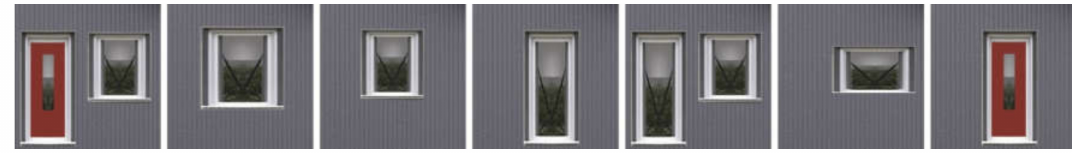
Figure 8. Example of building facade elements with textures extracted from IKEA’s BoKlok project catalogue, used in P8.